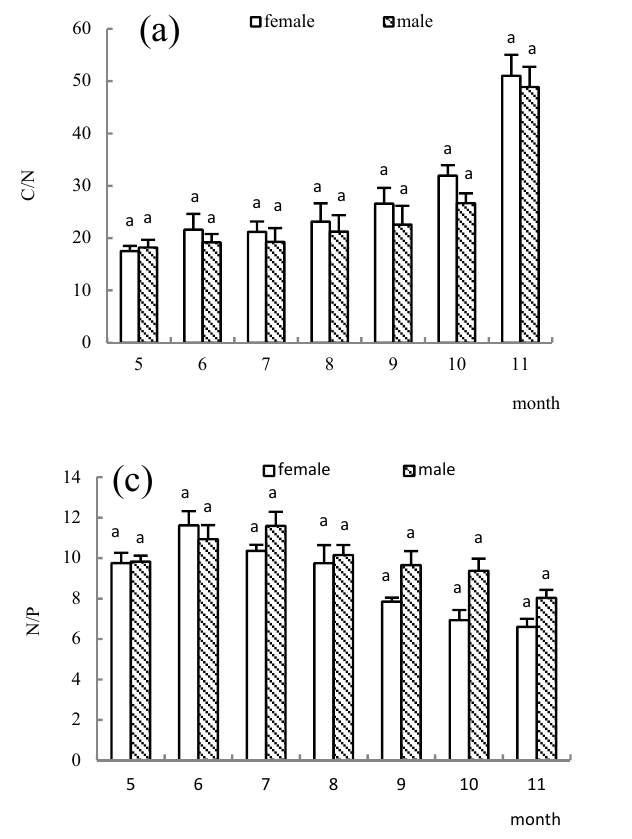
Figure 7. Comparation of C/N ( a ), C/P ( b ), N/P ( c ) ratios in leaf of female and male plants of F. velutina during the growing season. Note: Means not sharing the same letter of female and male plants in the same month indicated significant differences between males and females at an alpha level of 0.05, according to one-way ANOVA.